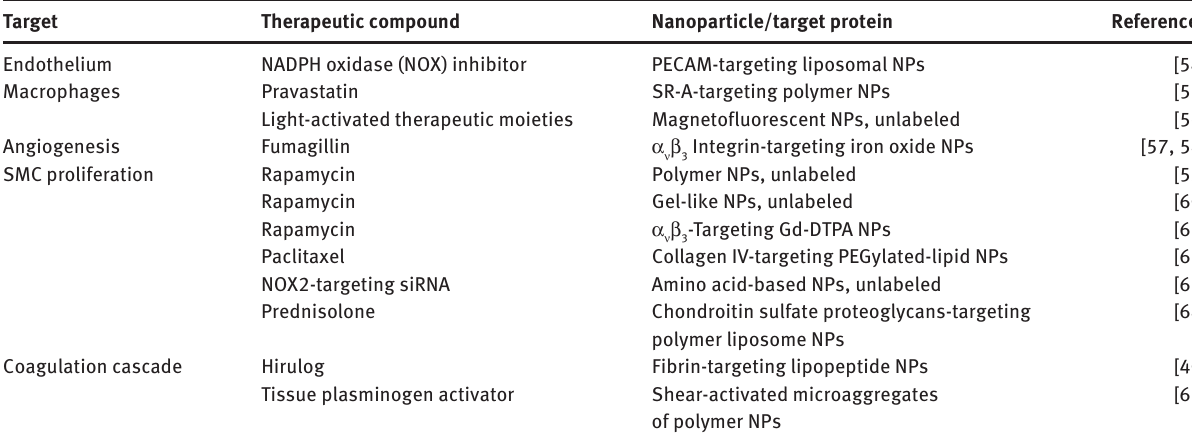
Table 2 The therapeutic targets of the nanoparticles in cardiovascular